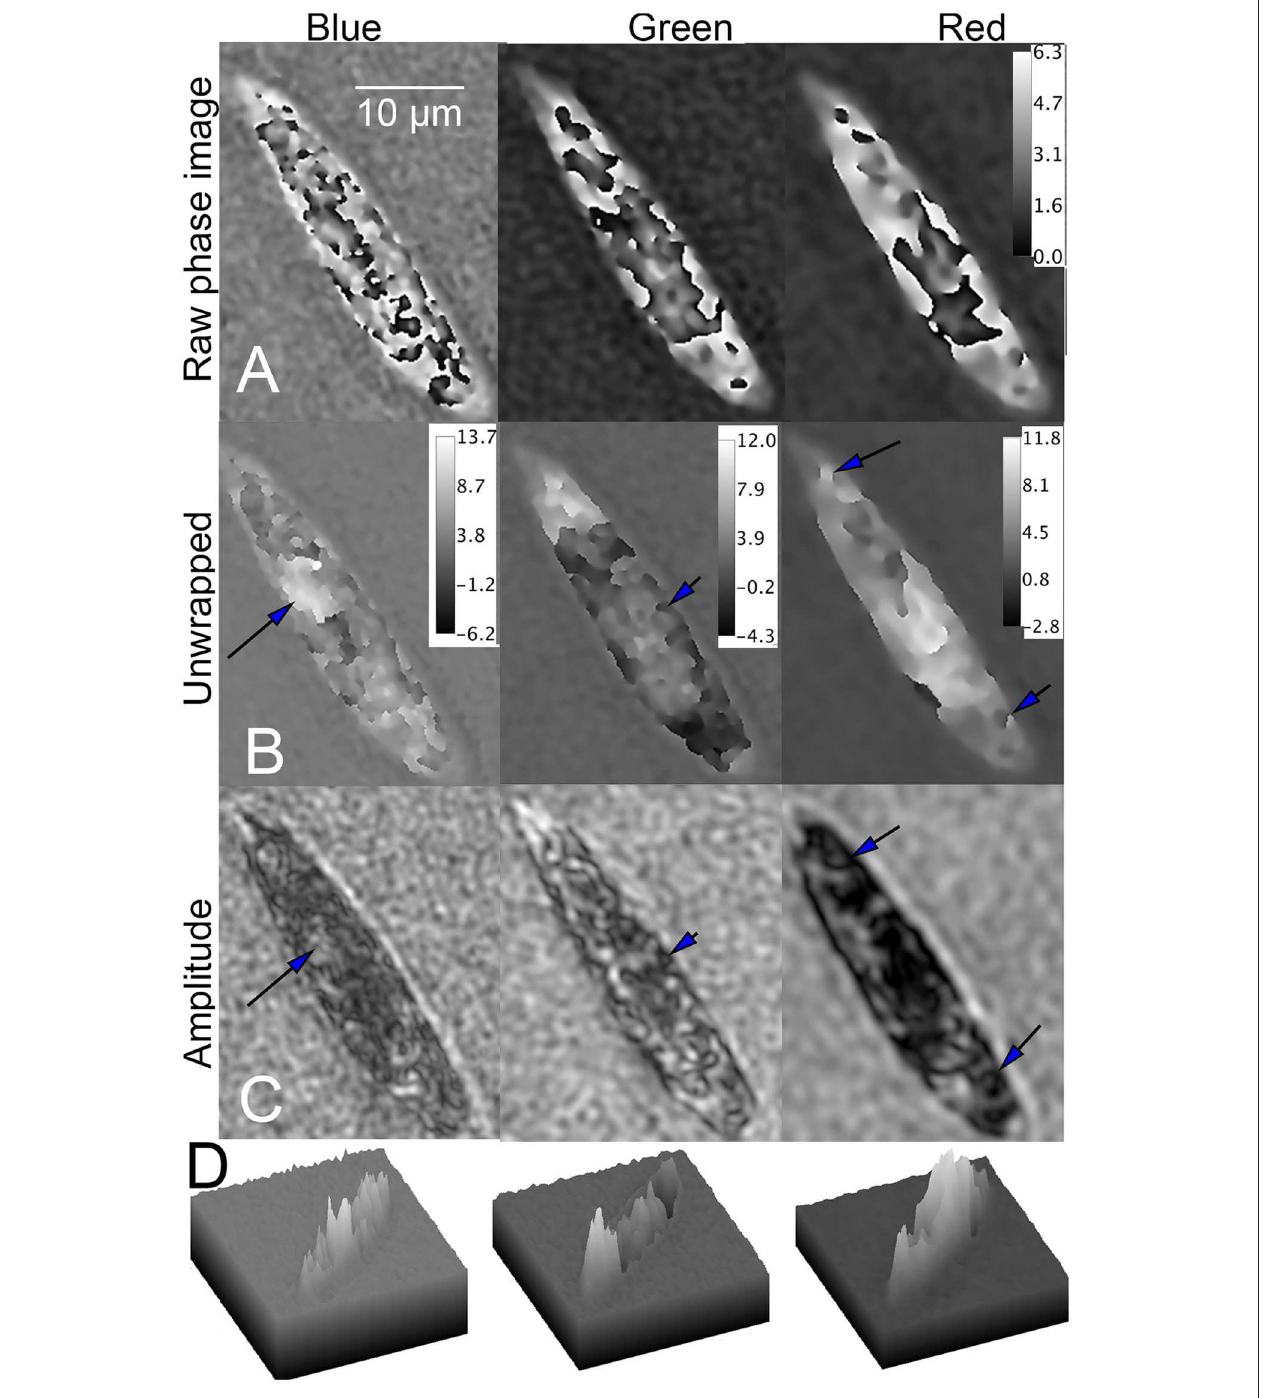
FIGURE 9 | Phase unwrapping of wild-type Euglena in three wavelengths. Phase scale bars are in radians. The spatial scale bar applies to all panels. (A) Raw phase image showing decreasing wrapping with increasing wavelength. (B) Unwrapped phase images compared with (C) amplitude image. In the blue (Left), the nucleus can be seen (arrow). In green (Center), features at the edge of the cell correspond in amplitude and phase (arrow), but the phase in the central part of the cell is almost featureless. In red (Right), areas of both positive and negative contrast are seen (arrows), with large areas of positive phase contrast corresponding to dark areas in amplitude. (D) Surface plot of phase shifts in blue (left), green (center), and red (right).